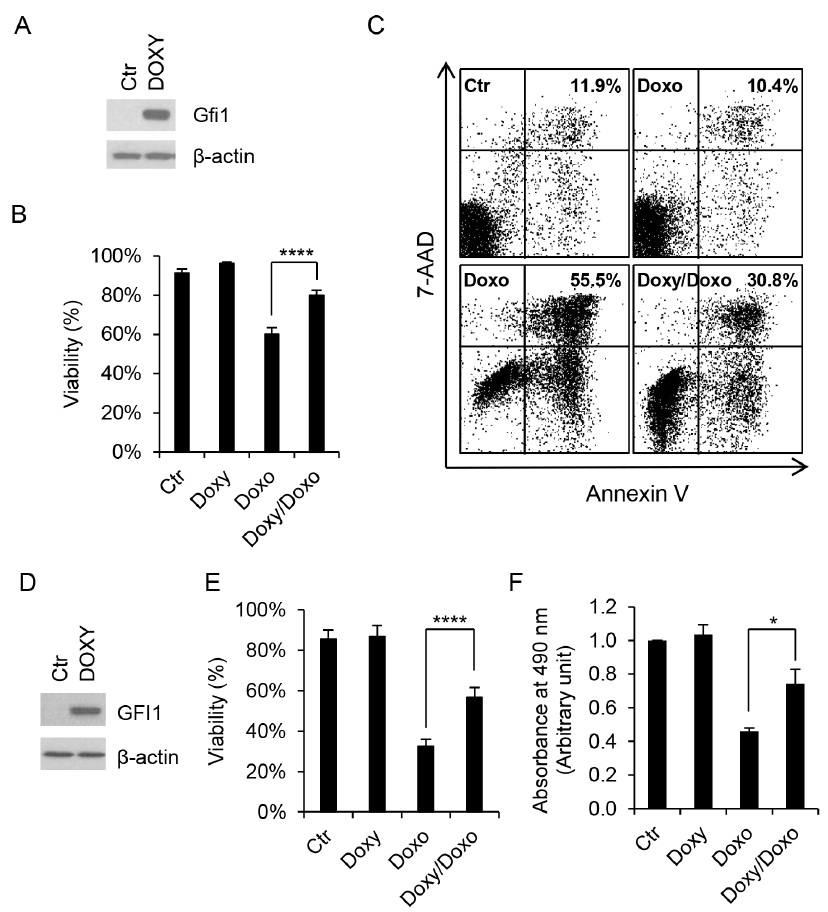
Figure 7. Overexpression of Gfi1 inhibits DNA damage-induced cell death. Ba/F3 (A–C) and Ramos (D–F) cells were transduced with the inducible lentiviral expression construct for Gfi1 and examined for Gfi1 expression by Western blot analysis after incubation with Doxy (1 m g/ml) for 24 hrs (A and D). Cells were then exposed to Doxo (100 ng/ml for Ba/F3 cells and 2 mg/ml for Ramos cells) for 18 hrs with or without preincubation with Doxy (1 m g/ml) for 24 hrs. Cell viabilities were determined by exclusion of trypan blue staining (B and E), percentages of apoptotic (annexin V- positive) cells were assessed by flow cytometry after staining with annexin V and 7-AAD (C), and the numbers of living cells were quantitated by MTS assay